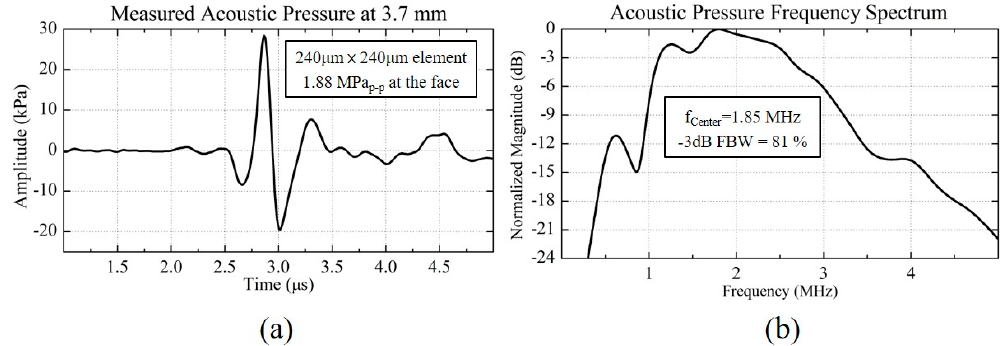
Figure 8. Measured acoustic pressure of the plane 2D CMUT element at 3.7 mm distance. ( a ) Transient pressure and ( b ) its frequency spectrum.